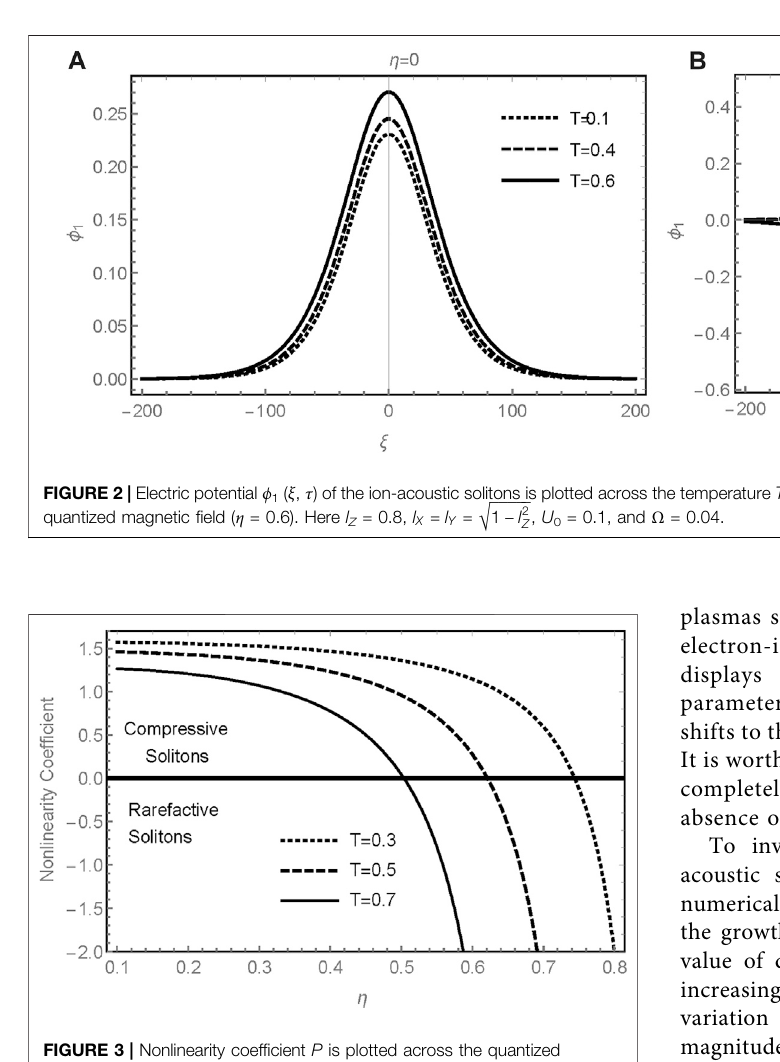
FIGURE 3 | Nonlinearity coef fi cient P is plotted across the quantized magnetic fi eld parameter η for different values of temperature T .